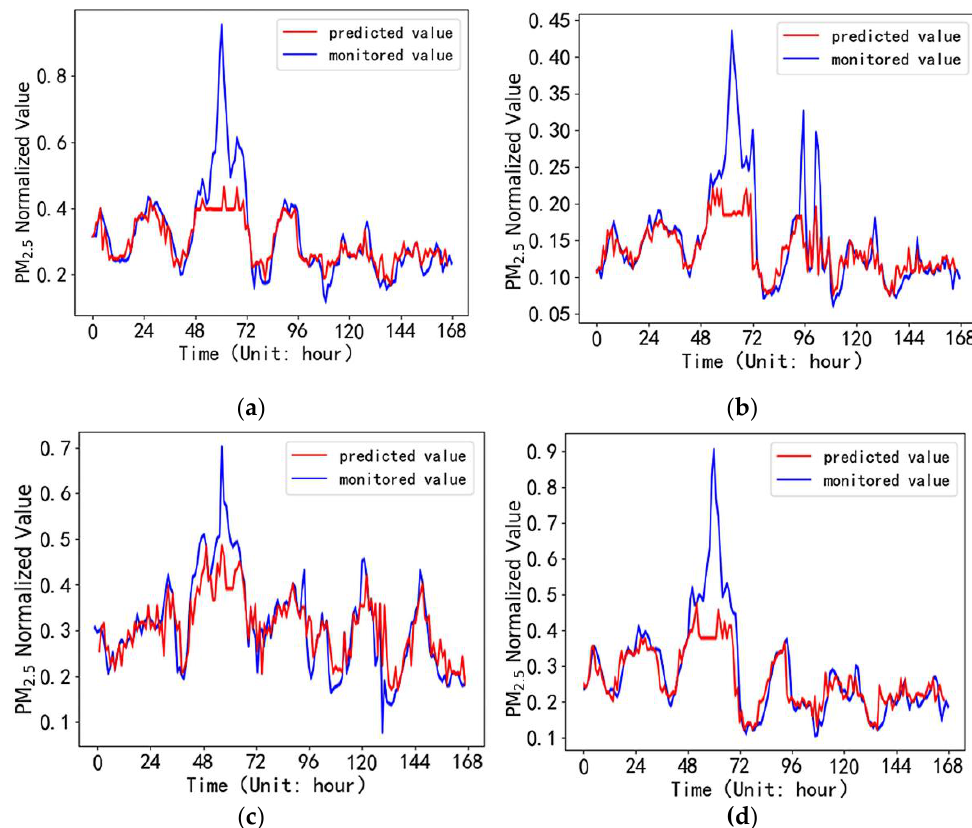
Figure 6. Comparison between predicted values and monitored values by SVR model in the coming week: ( a ) High-tech Zone Site; ( b ) Shangcheng Community Site; ( c ) Liuhe Countryside Site; ( d ) NJAU- Pukou Campus